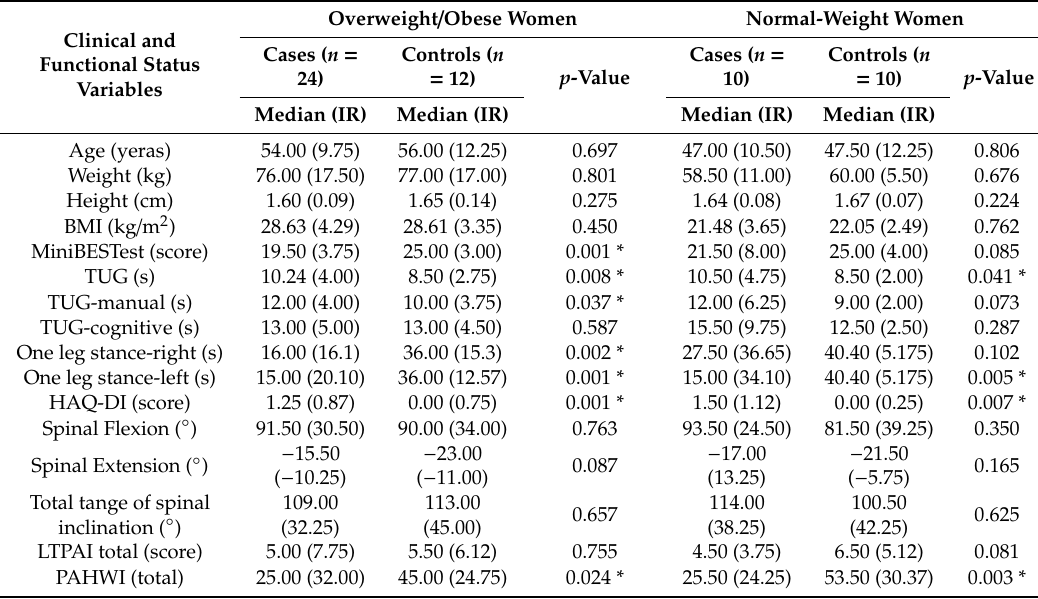
Table 2. Median (IR) and between-group di ff erences for functional status in overweight / obese women and normal-weight women in FMS patients and healthy controls.